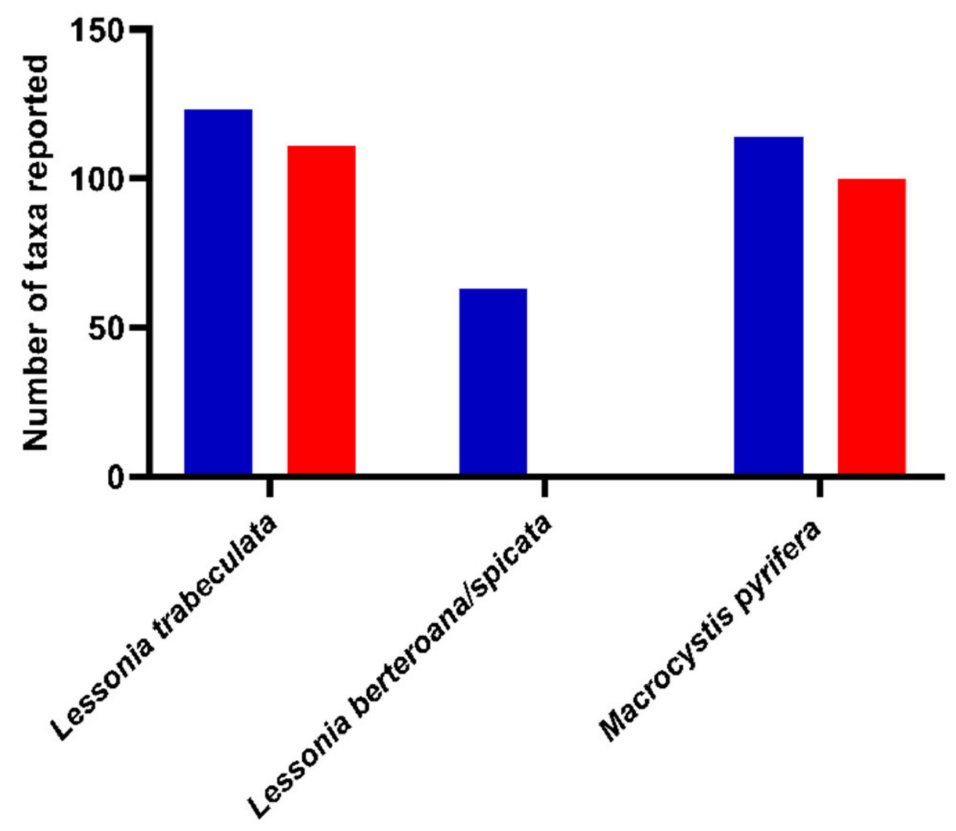
Figure 5. Number of kelp-forest associated taxa reported per kelp species in Chile (blue) and Peru